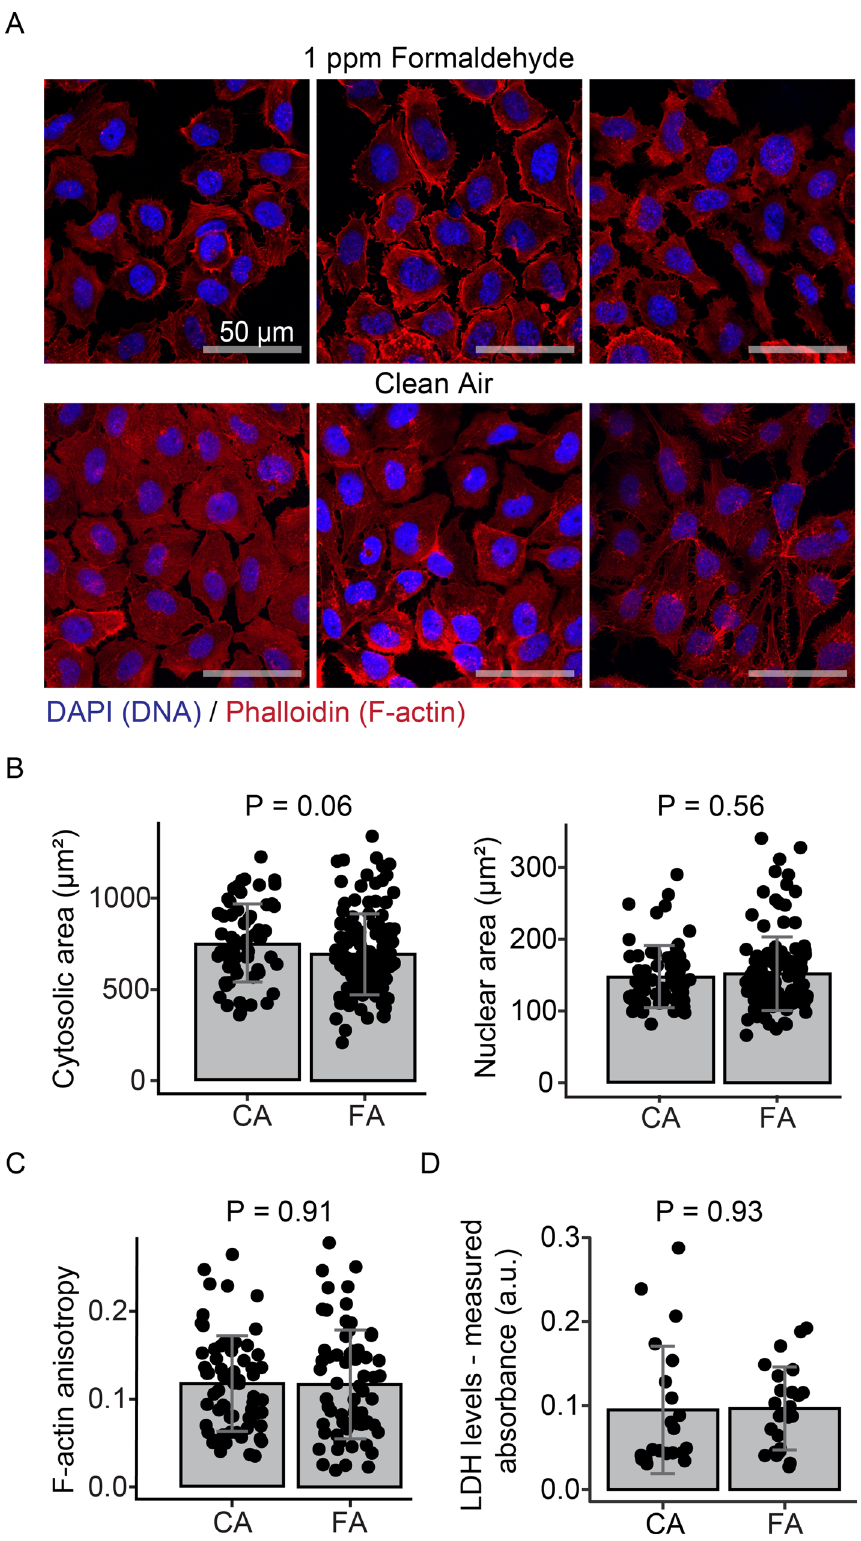
Figure 1. Minimal toxicity effects in BEAS-2B cells exposed to 1 ppm formaldehyde. ( A ) Representative images of BEAS-2B cells treated with formaldehyde and clean air (N = 3). Confocal fluorescent microscopy of cells stained with Alexa Fluor 594 phalloidin for F-actin (red) and DAPI for nuclei (blue) using an objective magnification of 63X. ( B ) No significant changes in cytosol and nuclear size were found after formaldehyde (FA) treatment as compared to clean air (CA) controls (N > 65 cells). ( C ) No significant changes in F-actin organization in exposed cells. An anisotropy score of 0 is given for no order (purely isotropic fibrils), and 1 is given for perfectly parallel fibrils (purely anisotropic arrays). This analysis was conducted in 10 µm × 5 µm regions on 65 cells per treatment. ( D ) LDH activity levels assayed after two hours of exposure and six hours recovery show no significant differences in exposed cells. Statistical difference was computed by t -test analysis and error bars are expressed as one standard